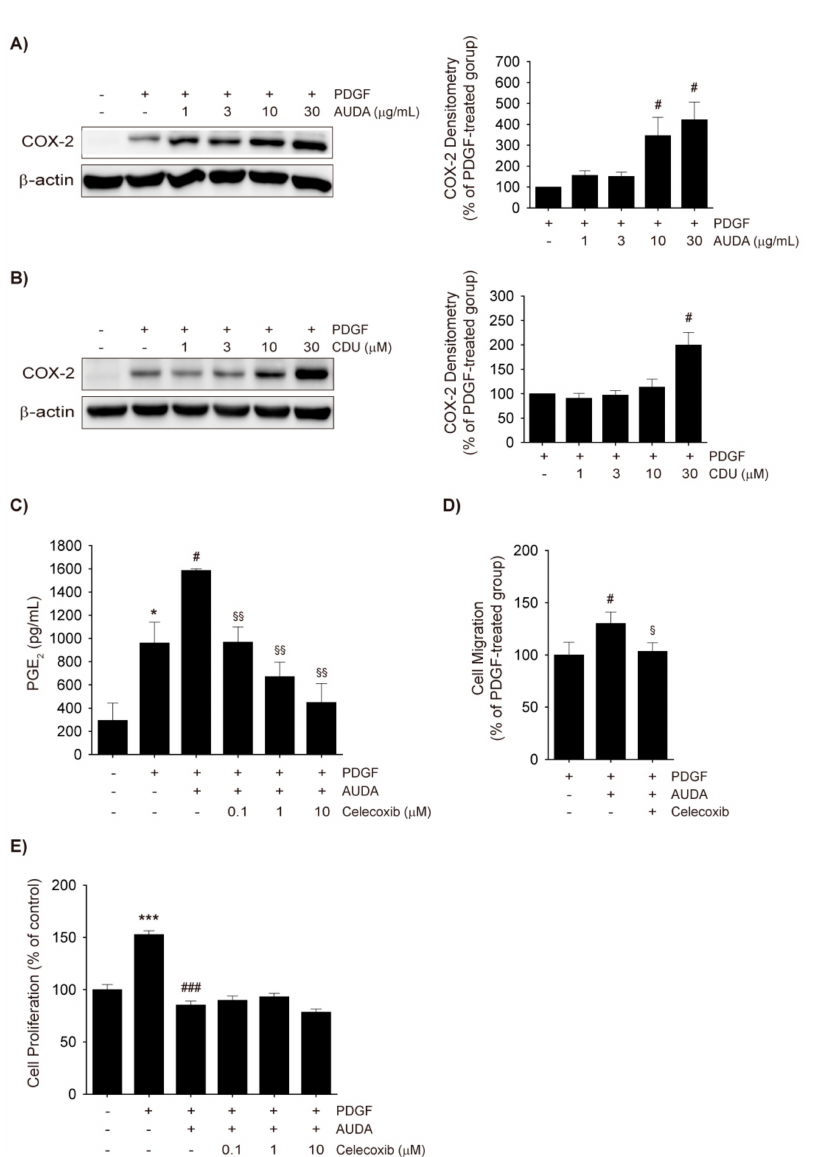
Figure 4. Cyclooxygenase-2 (COX-2) upregulation by sEH inhibitors and its role in VSMC migration. ( A , B ) COX-2 upregulation by sEH inhibitors. VSMCs were preincubated with vehicle control, AUDA (( A ), 1–30 µ g/mL), or CDU (( B ), 1–30 µ M) for 30 min, and then stimulated with 30 ng/mL PDGF for 8 h. The total cell lysates were subjected to COX-2 immunoblotting ( n = 3); ( C ) PGE 2 enzyme-linked immunosorbent assay (ELISA). Rat VSMCs were preincubated with vehicle control or AUDA (10 µ g/mL) in the presence or absence of celecoxib (0.1–10 µ M) for 30 min and then exposed to 30 ng/mL PDGF for 24 h. The secreted PGE 2 levels in culture media were quantified by ELISA; ( D ) Effect of COX-2 inhibitor on VSMC migration. Cell migration was determined via Boyden chamber assay of VSMC incubated with vehicle control or 10 µ g/mL AUDA with or without 1 µ M celecoxib for 24 h. Culture media containing 30 ng/mL PDGF was added to the lower chamber as chemoattractant; ( E ) Effects of Celecoxib on VSMC proliferation. Rat VSMCs were preincubated with vehicle control or AUDA (10 µ g/mL) in the presence or absence of celecoxib (0.1–10 µ M) for 30 min and exposed to PDGF (30 ng/mL) for 48 h. VSMC proliferation was determined by MTT assay. Statistical significance is indicated as * p < 0.05; *** p < 0.001 vs. vehicle-treated control; # p < 0.05; ### p < 0.001 vs. PDGF-treated group; § p < 0.05; §§ p < 0.01 vs. PDGF + AUDA-treated